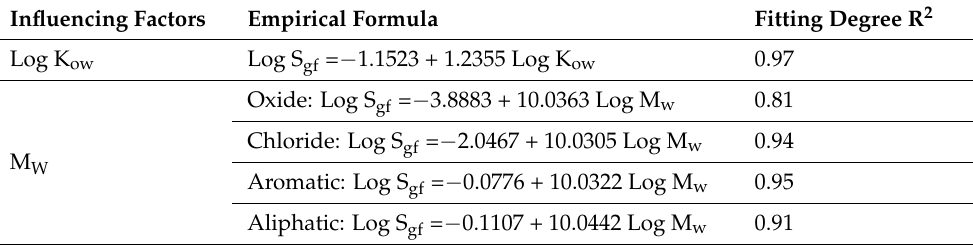
Table 3. Empirical formula of the partition coefficient of organic pollutants through HDPE GM